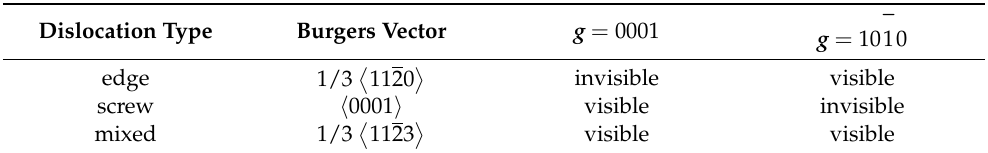
Table 2. Application of the invisibility criterion for threading dislocations in the wurzite GaN and InN structures; g is the operating reflection in